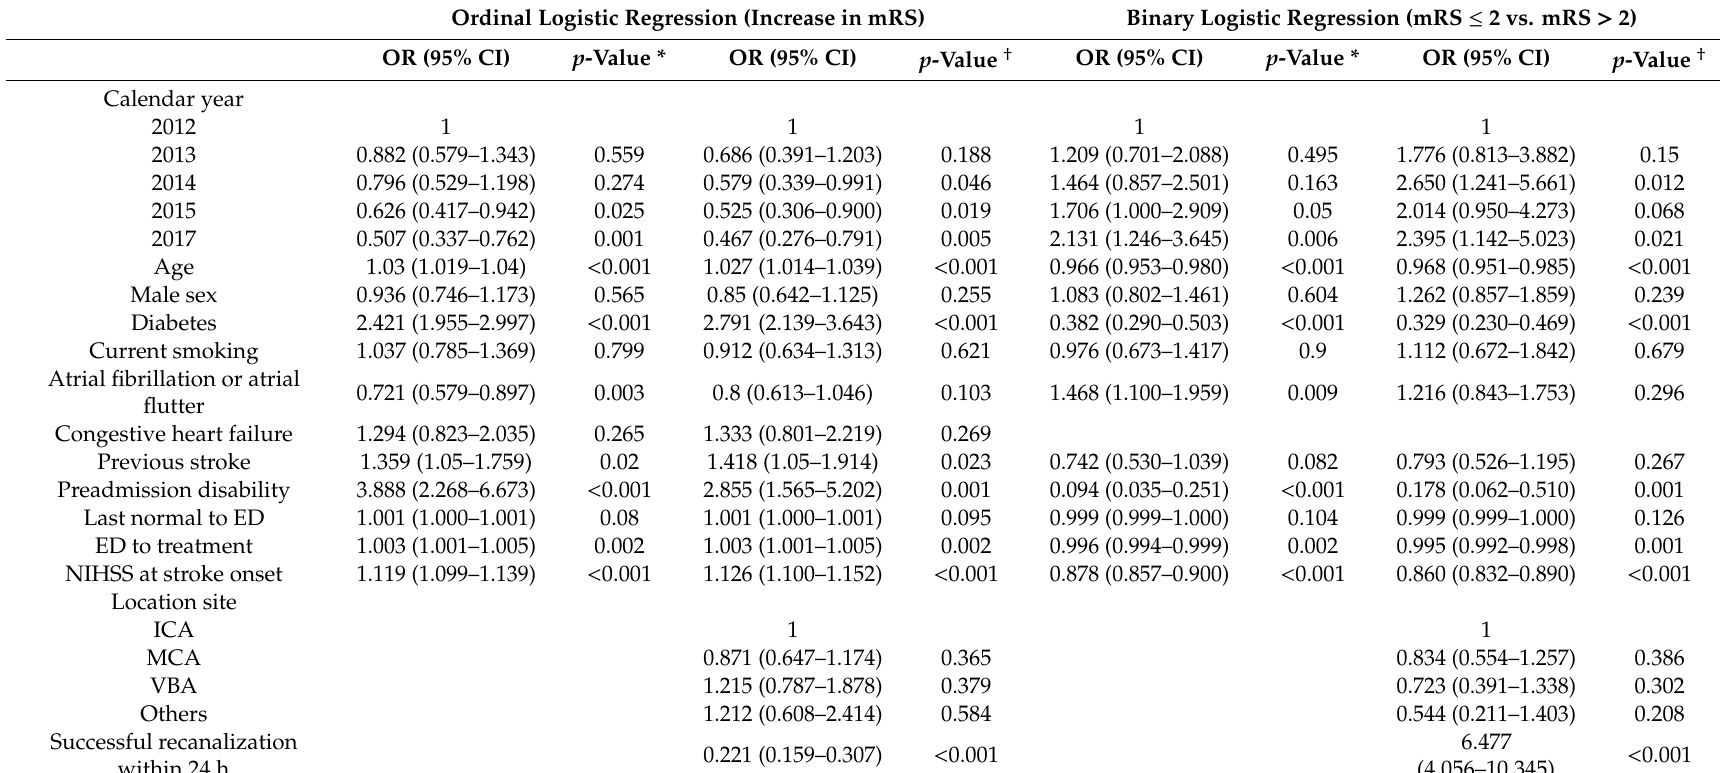
Table 3. Independent determinants for functional outcome at 90